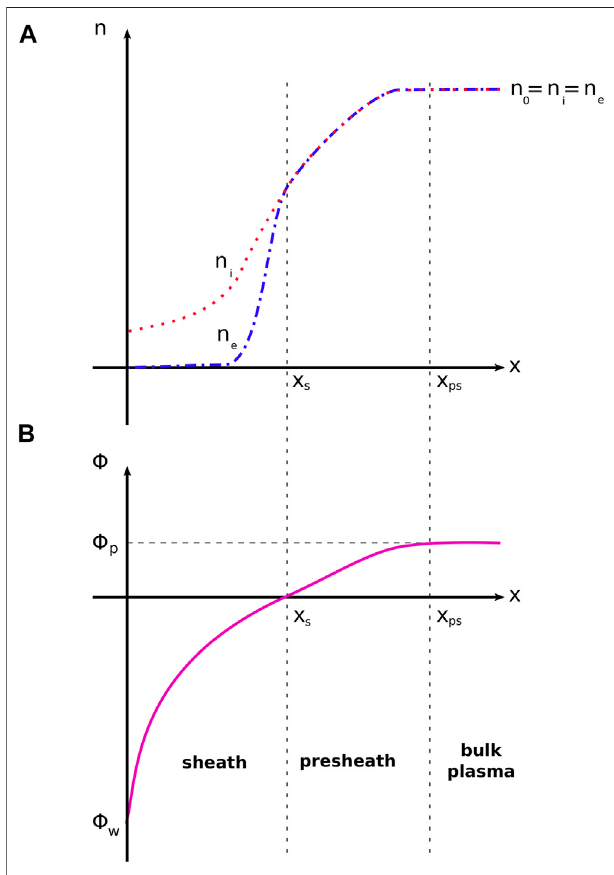
FIGURE4| Regionsinthetransitionbetweenthebulkplasmaandasurface in contact with a plasma, such as the inner con fi nement surfaces in a HPS or the surface of an electrostatic probe immersed in the plasma. Graph (A) shows the behavior of the electron and ion density, while graph (B) shows the electric potential. The surface is located at x = 0. The bulk plasma region is located at x > x ps , where the plasma is quasineutral and its potential is the plasma potential Φ p . The presheath is the region x s < x < x ps where both the plasma density and potentialdecreasegraduallyas x → x s .Thesheathproperlybeginsatthepoint x = x s ≈ λ De , where the ions acquire the Bohm velocity u i (cid:1) u B (cid:1) −( k B T e / m i ) 1/2 . Quasineutrality is broken, the electron density quickly decreases to zero and the potential drops gradually towards the wall potential Φ w at x =